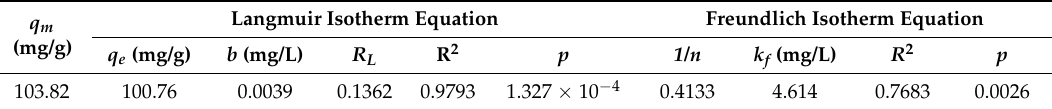
Figure 9. Langmuir ( a ) and Freundlich ( b ) isotherm equations fitting curves of the experimental data. (Adsorption experiments-sample dosage: 0.05 g; pH value: 5.16; temperature: 60 ◦ C; adsorption time: 40 min). Table 4. Adsorption equilibrium constants obtained from the Langmuir and Freundlich isotherms for zinc(II) adsorption onto XSBLAC. (Adsorption experiment sample dosage: 0.05 g; pH value: 5.2; temperature: 60 ◦ C; adsorption time: 40